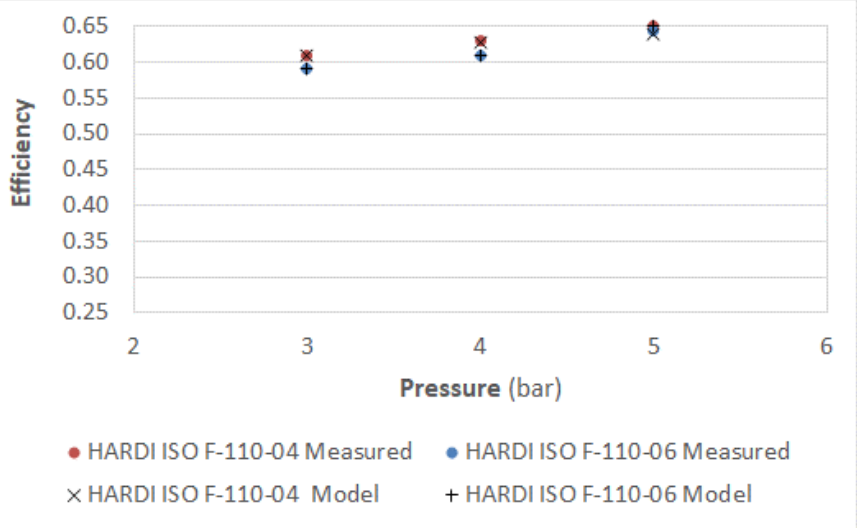
ffi ciency vs. working Figure 14. Variation in mean cooling efficiency vs. working pressure. Figure 14. Variation in mean cooling e Figure 14. Variation in mean cooling efficiency vs. working pressure.